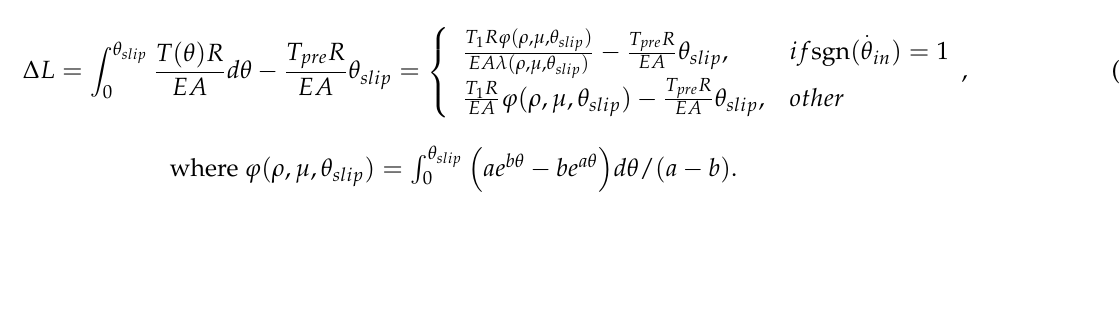
Figure 3a is the tension distribution diagram of the cable in the process of